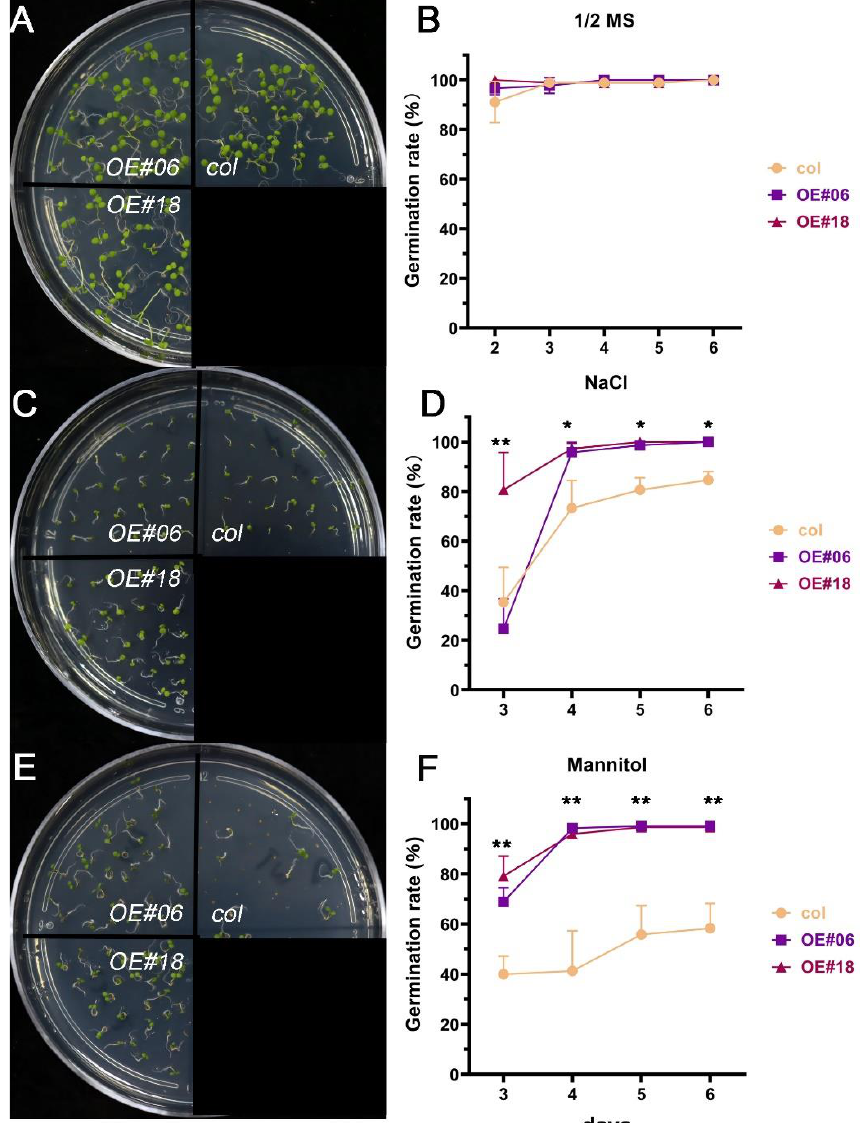
Figure 4. Effects of osmotic stress on Arabidopsis seed germination. ( A ) Growth status and germination rate ( B ) of Arabidopsis thaliana grown on half-strength MS medium (control). ( C ) Growth status and germination rate ( D ) on half-strength MS medium with 125 mM NaCl. ( E ) Growth status and germination rate ( F ) on half-strength MS medium with 225 mM mannitol. Using a total of 30 seeds per line, the number of germinations was counted from the second day for 7 days. The growth of all lines in half-strength MS medium was used as control. Each value represents three replicate experiments. Values are shown as means ± SD. * p < 0.05; ** p < 0.01.